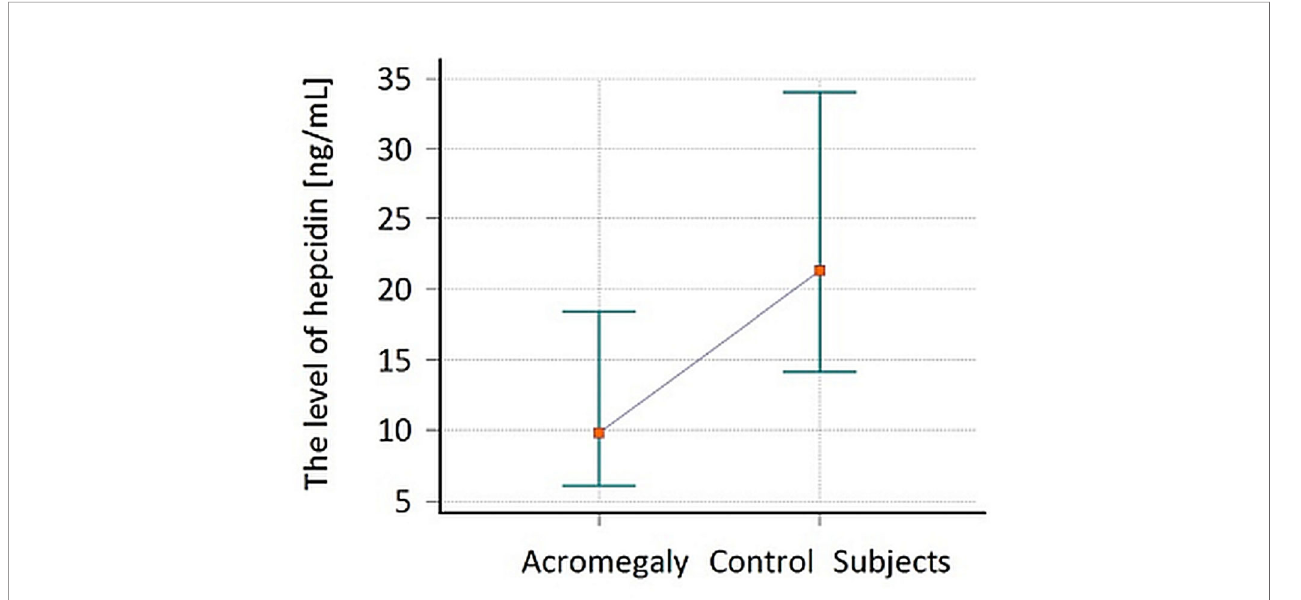
FIGURE 1 | The comparison of hepcidin level in patients with acromegaly (AG) at the time of the diagnosis and in the control subjects (CS). Values are expressed as median and interquartile range